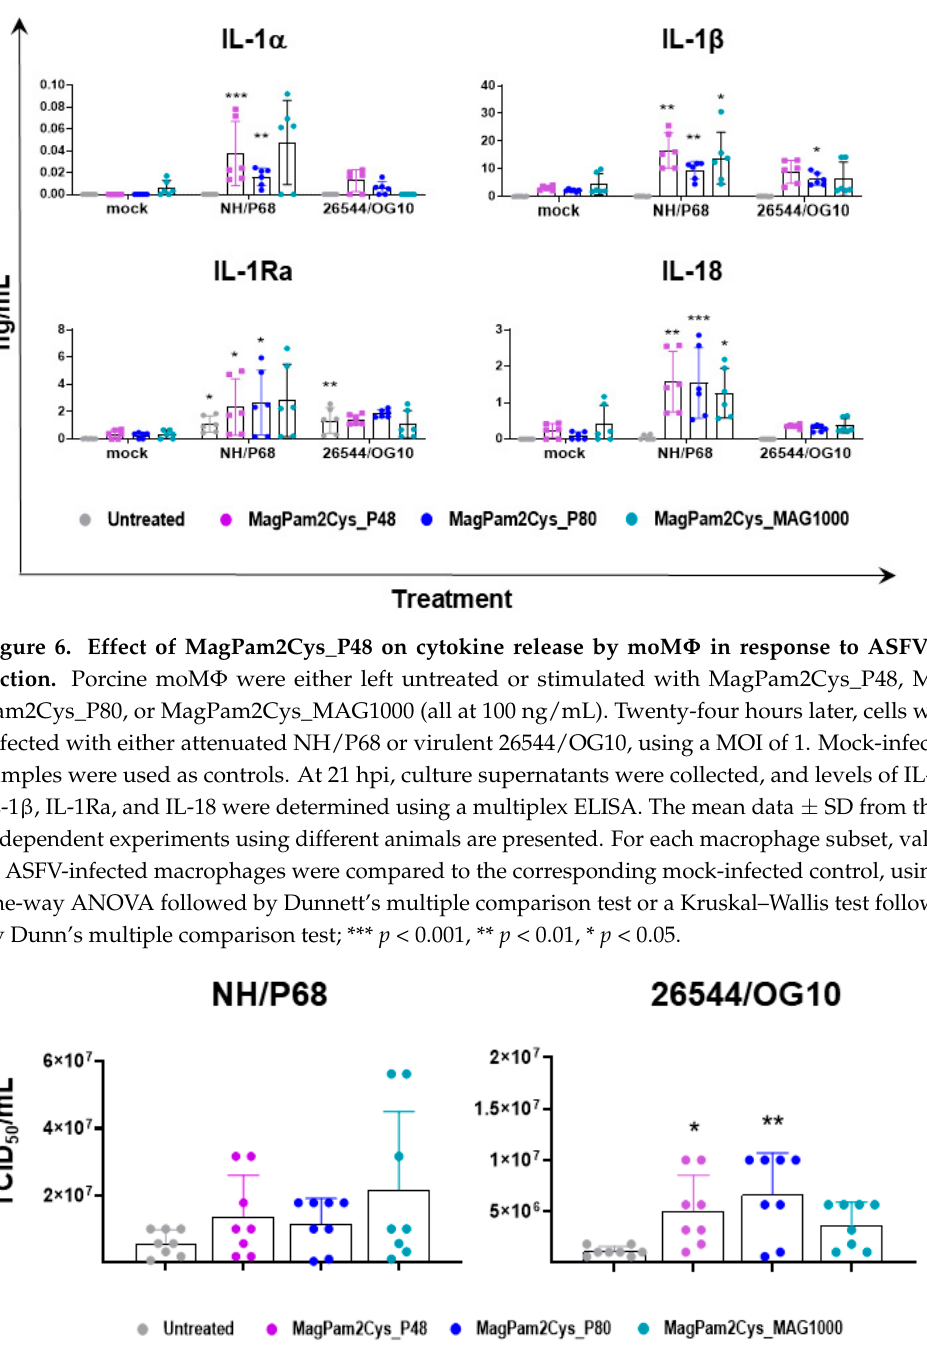
Figure 7. Impact of diverse synthetic diacylated lipopeptides on porcine moM Φ ability to sustain ASFV replication. Porcine moM Φ were left untreated or stimulated with MagPam2Cys_P48, MagPam2Cys_P80, or MagPam2Cys_MAG1000 (all at 100 ng/mL). Cells were infected with either attenuated NH/P68 or virulent 26544/OG10, using a MOI of 0.01. At 72 hpi, culture supernatants were collected, and the levels of infectious viral progeny were determined by titration (TCID 50 /mL). The mean data + SD from four independent experiments utilizing different blood donors are shown. For each isolate (NH/P68 or 26544/OG10), values of treated macrophages were compared to the corresponding untreated control (moM Φ ), using a Kruskal–Wallis test followed by a Dunn’s multiple comparison test; ** p < 0.01, * p < 0.05.